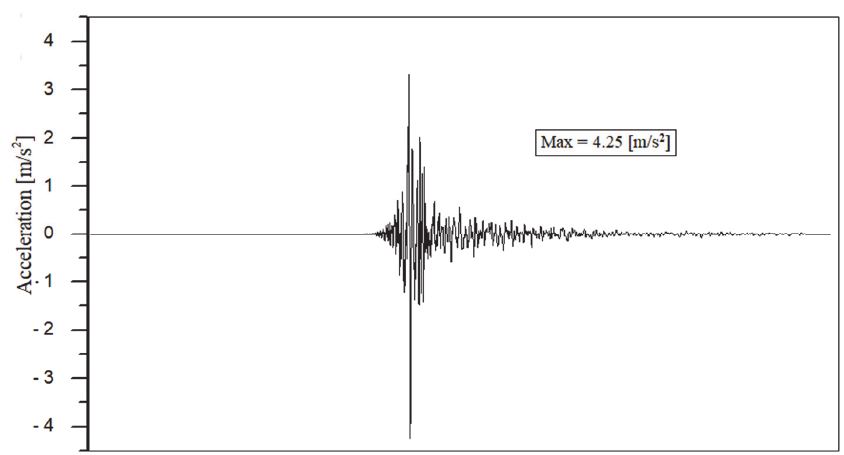
Figure 4: Acceleration history of earthquake used in numerical analysis